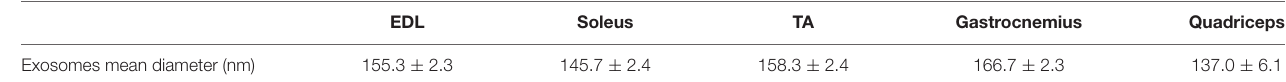
FIGURE 7 | Characterization of muscle-derived exosomes. Skeletal muscles were harvested from 16-week-old wild-type mice and incubated in tissue culture medium for 24 h, allowing for the tissues to secrete exosomes in the surrounding environment. Muscle-derived exosomes were then isolated from the culture medium and characterized based on their physical and molecular properties. (A) Micrographs were obtained using scanning electron microscopy at 50,000 × magnification illustrating spherical structures with 100–150 nm diameter. (B) TRPS analysis demonstrated that isolated muscle-derived exosomes have 121 nm mean diameter. (C) Western blot analysis was performed for the detection of positive exosomal markers CD63, CD81, and TSG101 in exosomal protein extracts (E) derived from skeletal muscles compared to cell protein lysates (CL). Calnexin was served as negative control. TABLE 1 | The five hindlimb skeletal muscles secrete exosomes of the same size. EDL Soleus